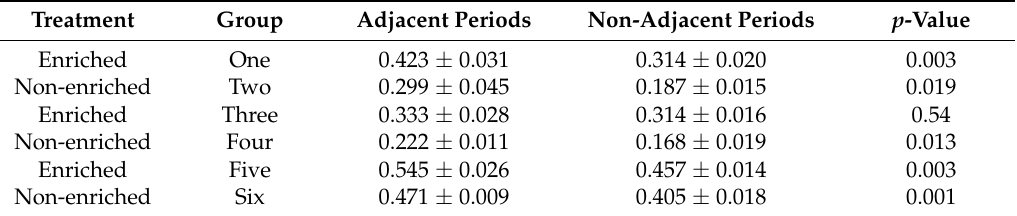
Table 5. Mean ± SEM of the correlational R -values between adjacent and non-adjacent 10-day periods that were assessed for the percentage of association between all possible pairs of hens 1